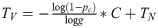
Estimating probability of protection parameter pc by linear regression of SFU/million PBMC against time to 1% parasitaemia in two PvTRAP vaccination experiments.Two sets of female BALB/c mice (n = 26, 34) were vaccinated with P. vivax TRAP delivered using viral vectors (adenovirus prime and MVA boost, 8 weeks apart). ELISpots were performed using PBMCs obtained from mice 2 weeks following boost immunization. Mice were challenged one week post-boost with either 5000 (experiment 1, red circles) or 2000 (experiment 2, black squares) PvCSP/PvTRAP transgenic P. berghei sporozoites. Time to reach 1% blood-stage parasitaemia was obtained by linear regression using daily thin blood smears. Linear regression using Prism and analysis of the slopes returns a pooled slope value of 9.62E-05 ± 2.17E-05, with the probability of the slopes being different of p = 0.63. From the equation TV=−log(1−pc)logg*C+TN where TV = time-to-1% in vaccinated mice, g = blood stage growth rate, C = SFU/million PBMC, TN = time-to-1% in naïve mice, and pC = probability of protection by a unit of C, and using a value of g = 3.5 ± 0.1, a value of pC = 1.21E-04 ± 2.72E-05 is obtained. Values shown ± SEM.